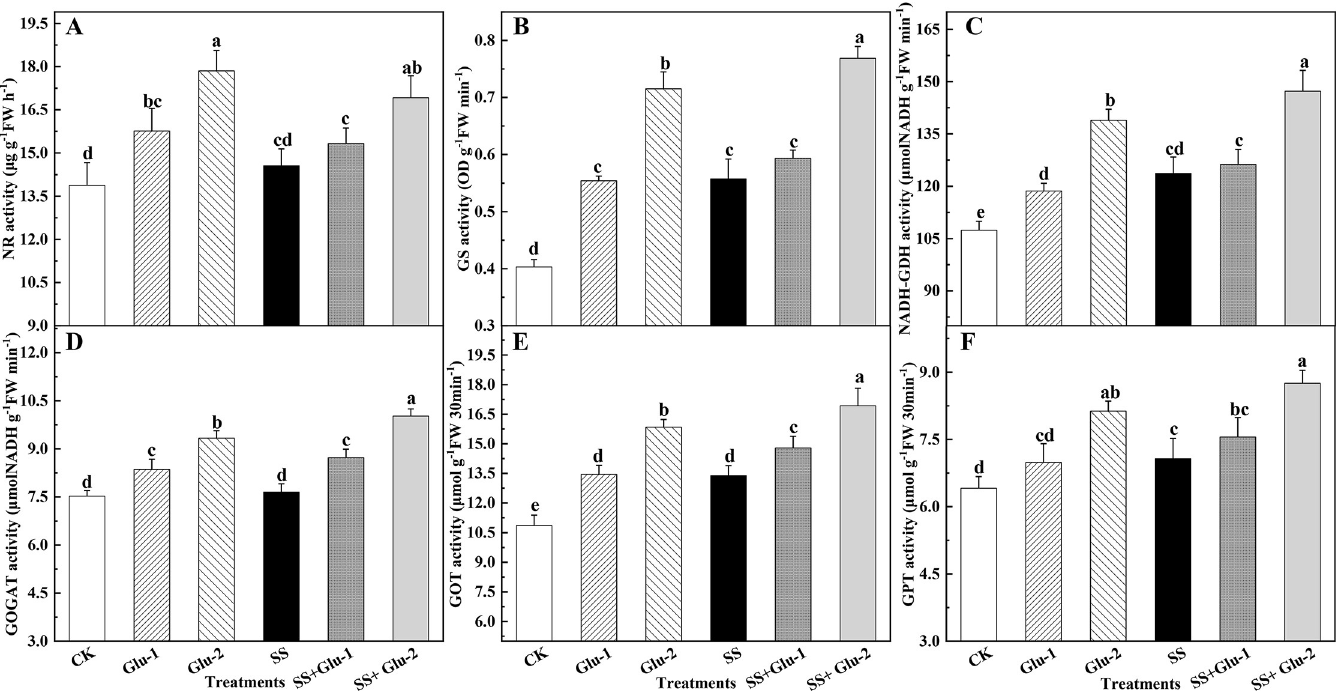
Fig 5. Key enzyme activities involved in nitrogen metabolism of root in the sterilized and non-sterilized soils with glucose addition at day 45. Different lowercase letters indicate significant differences between treatments ( P < 0.05). CK, non-sterilized soil without glucose addition; Glu-1, non-sterilized soil with low level of glucose addition; Glu-2, non-sterilized soil with high level of glucose addition; SS, sterilized soil without glucose addition; SS+Glu-1, sterilized soil with low level of glucose; SS +Glu-2, sterilized soil sterilization with high level of glucose addition.